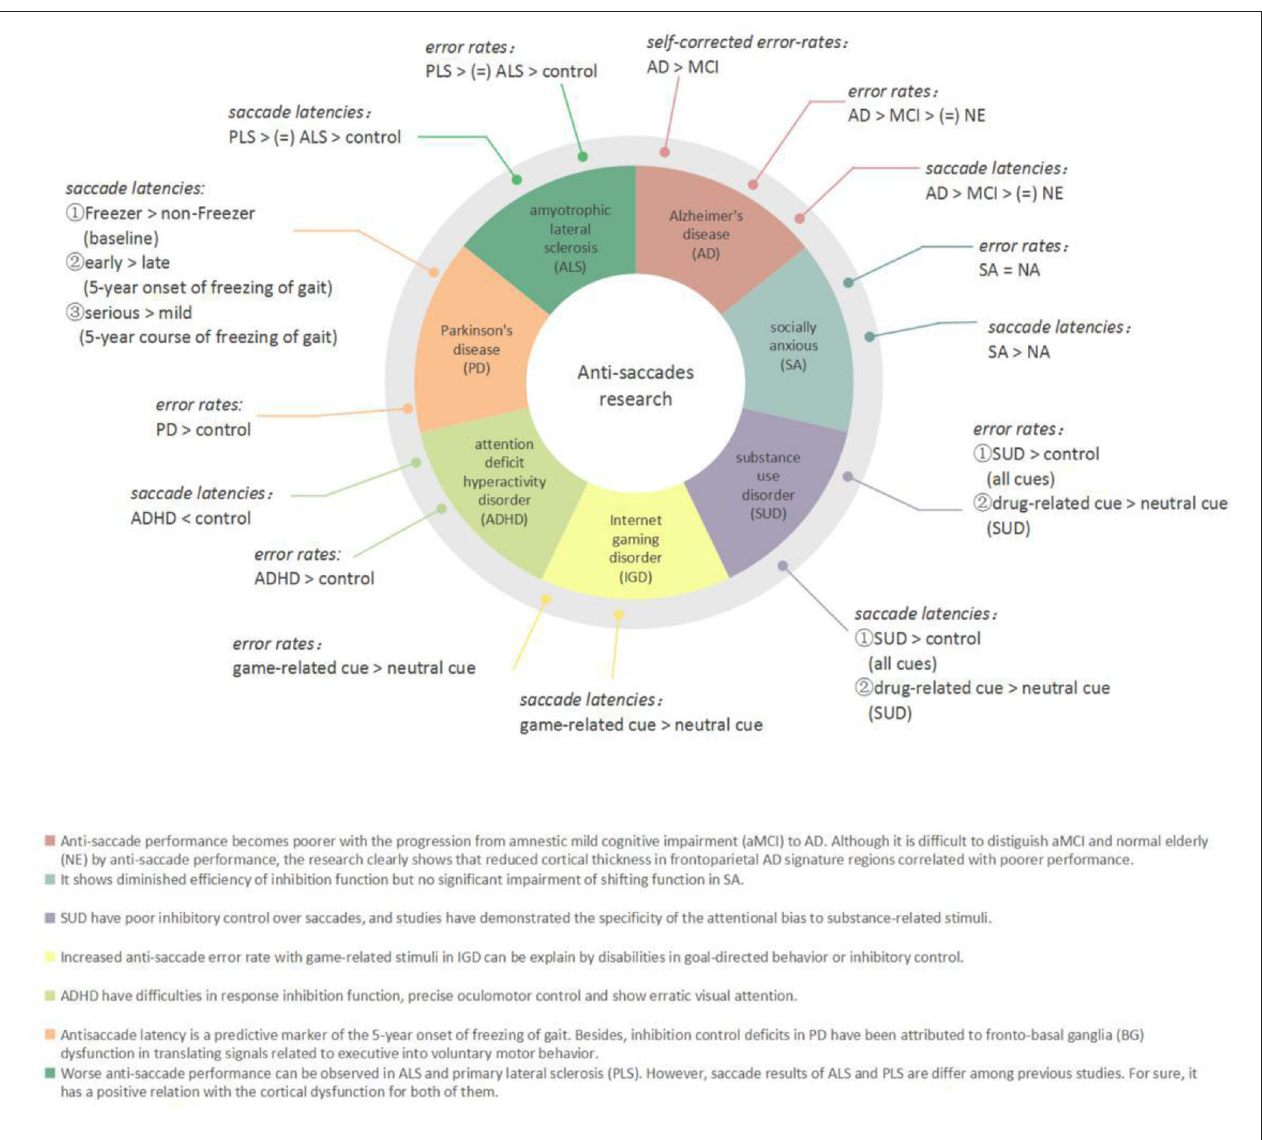
FIGURE 2 | Anti-saccades research in neurological and psychiatric